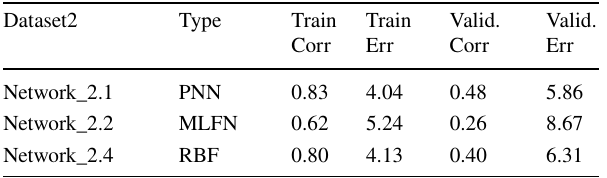
Table 8 Results of evaluation of various networks for the second